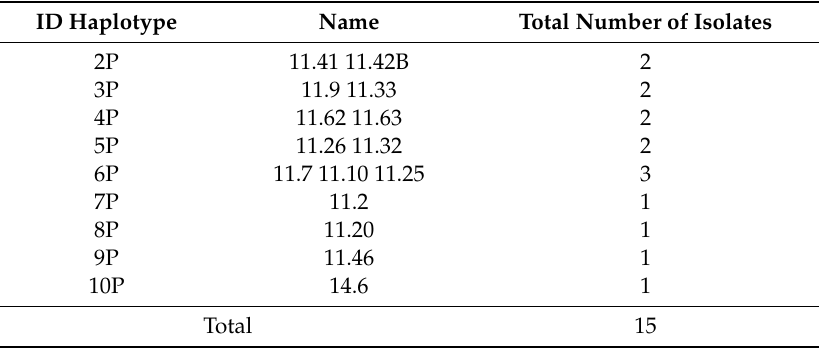
Table 4. Distribution of Pseudomonas RAPD